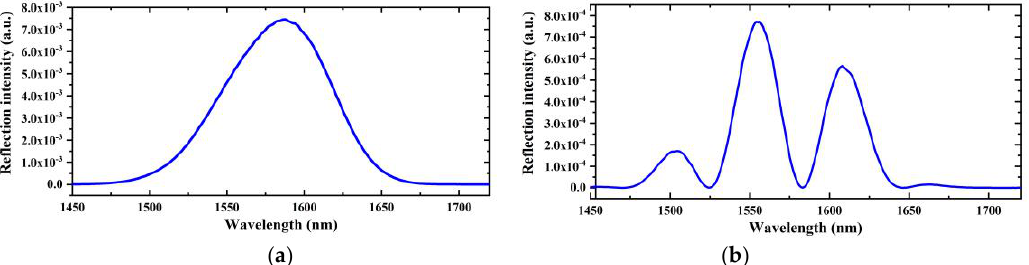
Figure 3. ( a ) Spectrum of a SLD with a center wavelength of 1568 nm and a 3 dB bandwidth of 98 nm, which has a Gaussian-like spectral distribution. ( b ) Reflection spectrum of an EFPI microcavity fiber-optic strain sensor, which exhibit several peaks can be used to determine the cavity length.